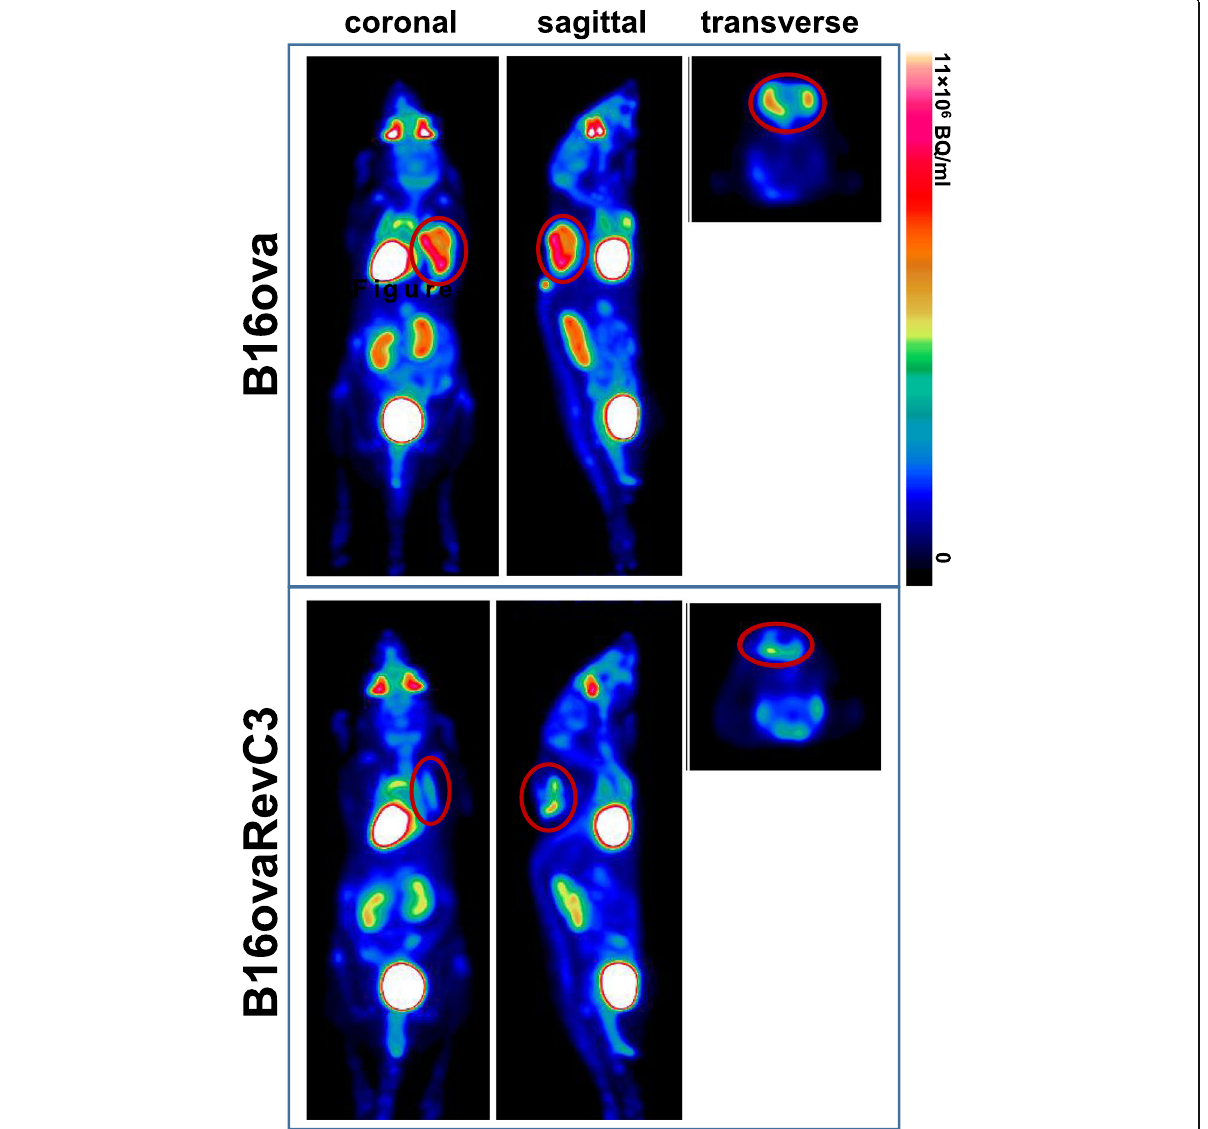
Fig. 5 18 F-FDG PET imaging. Representative PET images obtained with 18 F-FDG, 24 h after doxycycline administration in mice bearing B16ova